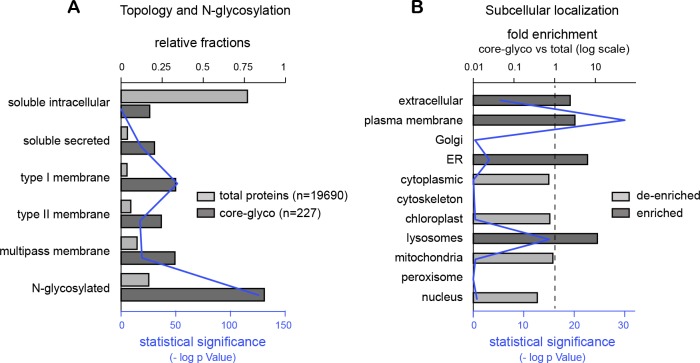
Evaluation of mass spectrometry data part 2.(A) Enrichment for secreted and transmembrane proteins among identified surface core-glycosylated proteins. Relative frequencies (solid bars) of soluble (intracellular or secreted), transmembrane and predicted N-glycoproteins among 'total' hippocampal proteins and 'core-glycosylated' surface proteins. Shown in blue (thin line) is the statistical significance (-log p value) of the difference between the two groups for the indicated category. (B) Fold enrichment of core-glycosylated proteins with annotations associated to the indicated subcellular compartments, and statistical significance (-log p value). Note the enrichment of cell-surface, secreted, lysosomal and endoplasmic reticulum proteins, but not Golgi proteins, among the core-glycosylated proteins. ***p<1x10−4; Hypergeometric test.